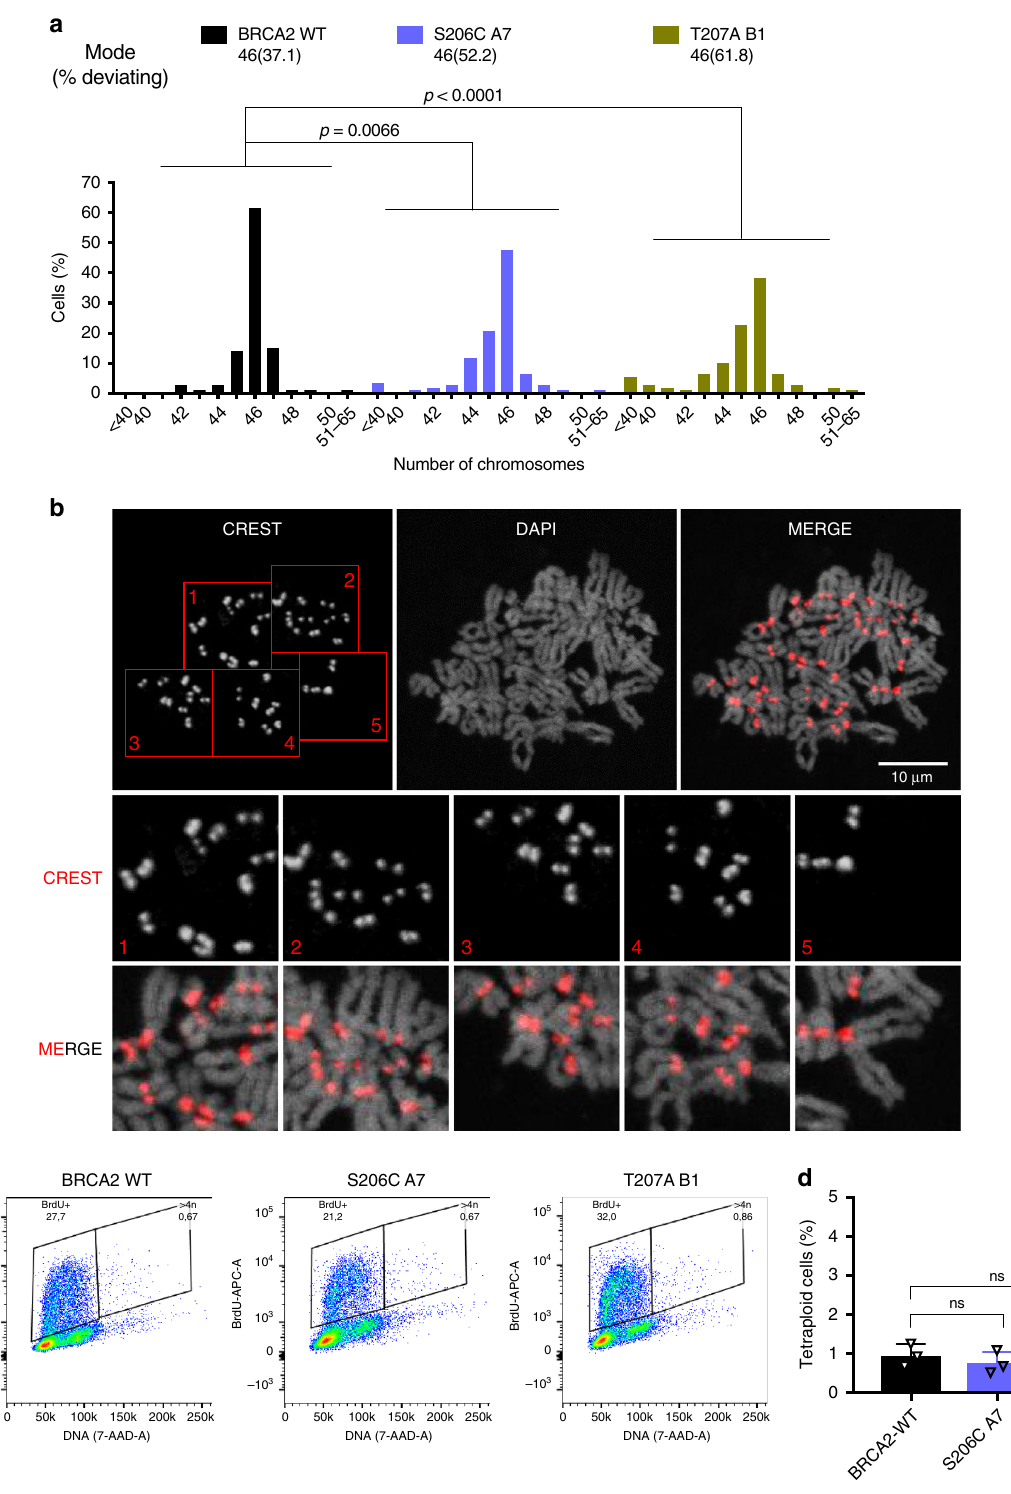
Cells bearing T207A and S206C variants display chromosome segregation errors including lagging chromosomes and chromo- some bridges (Fig. 7d, e). Importantly, these accumulated errors ultimately led to a broad spectrum of chromosome gains and losses (aneuploidy) compared to the wild type counterpart (Fig. 8a), but not to tetraploid cells (Fig. 8c, d), suggesting that cytokinesis per se, in which BRCA2 is also involved 11 – 13 , is not